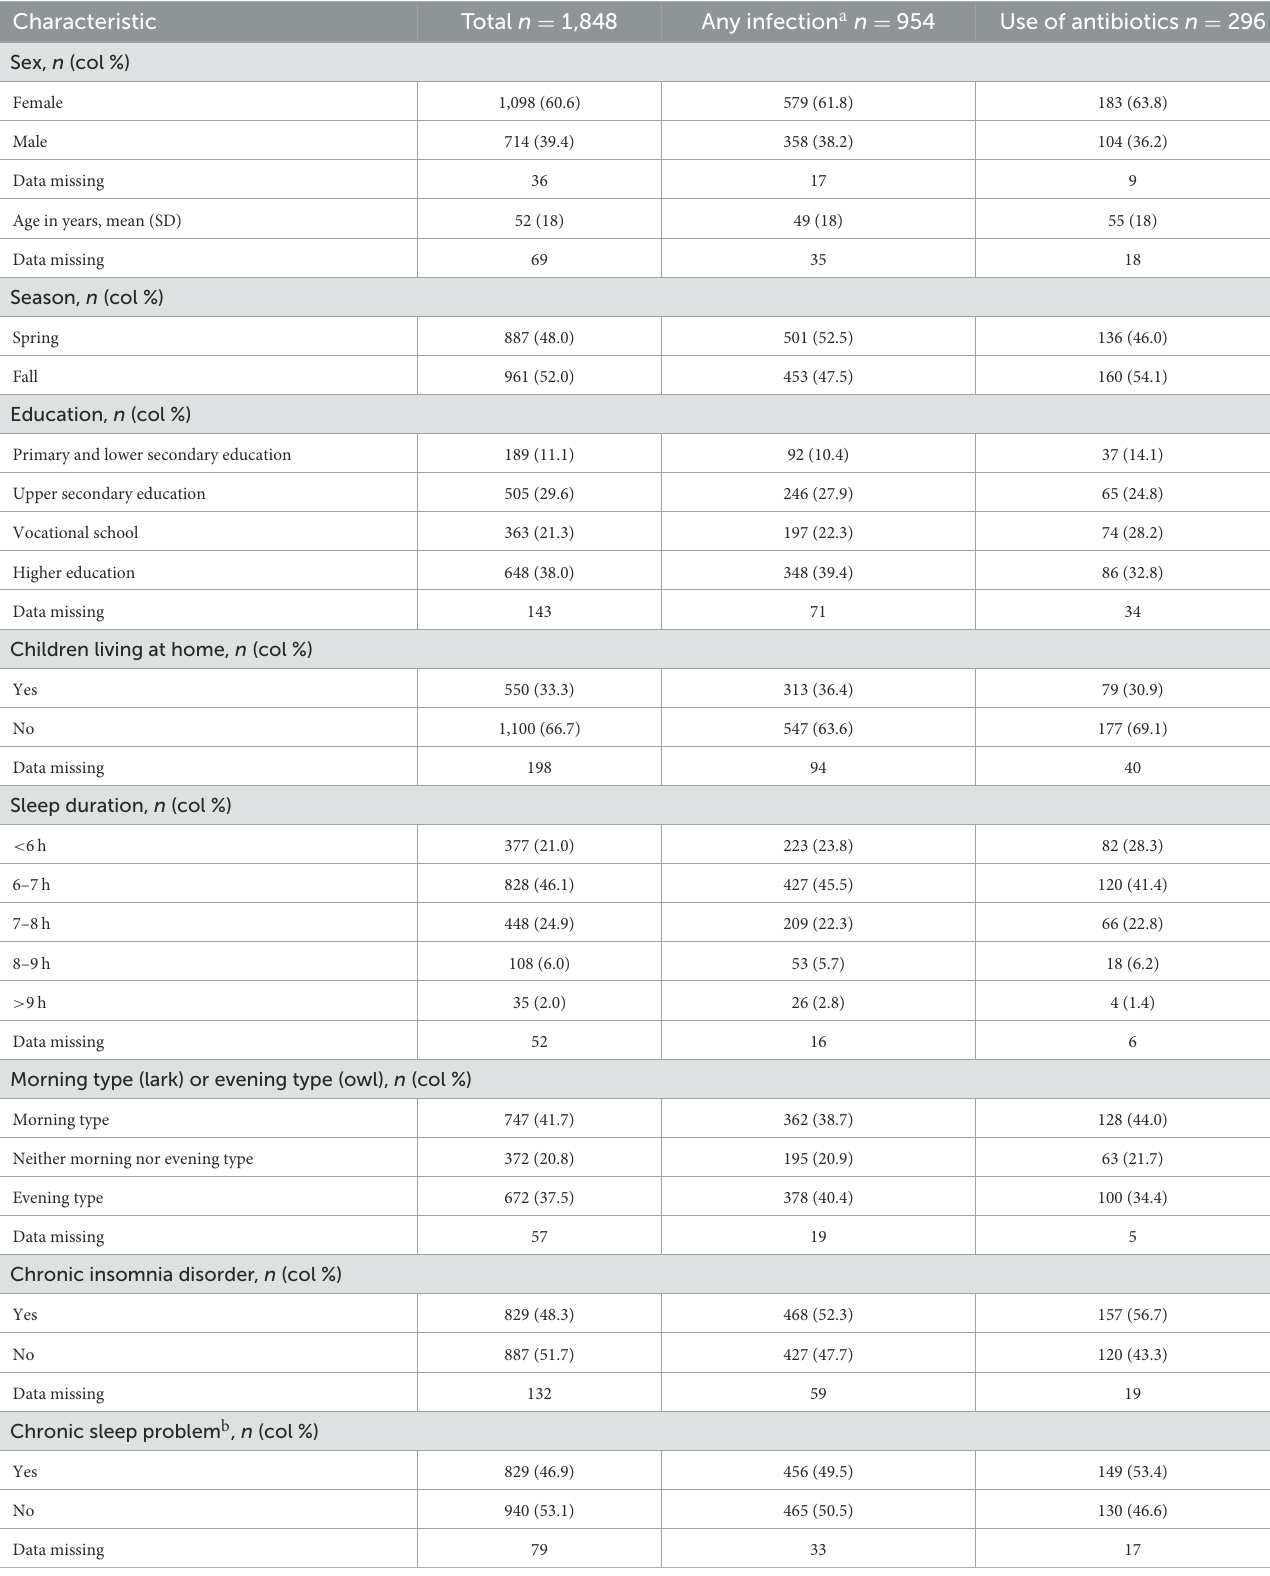
TABLE 1 Patient characteristics of 1,848 patients in Norway visiting their general practitioner during the spring and fall of 2020, total and for any type of infection and use of antibiotics.